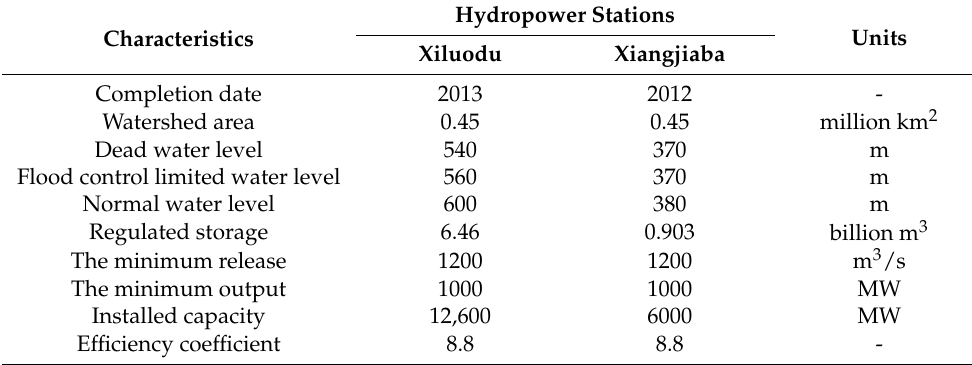
Figure 3. Location of XLD-XJB cascade reservoirs. Table 7. Characteristics information of XLD-XJB cascade